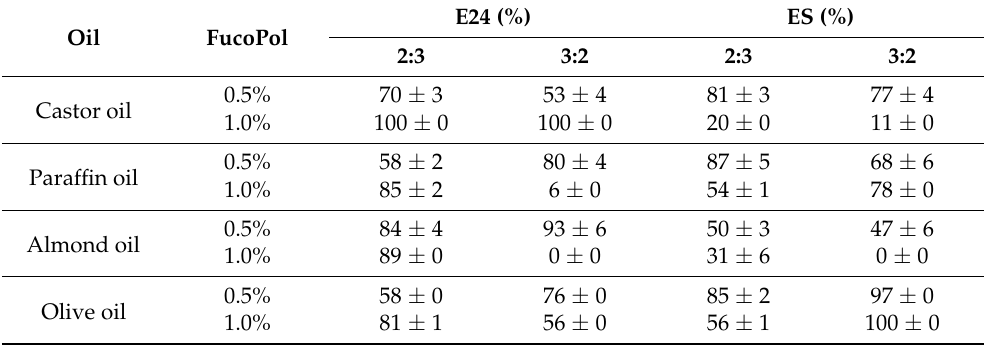
Table 2. Emulsification activity measured at 24 h (E24) and emulsions’ stability (ES) for the emulsions stabilized with FucoPol. Data are shown as the average ± standard deviation (SD) ( n = 3). Oil